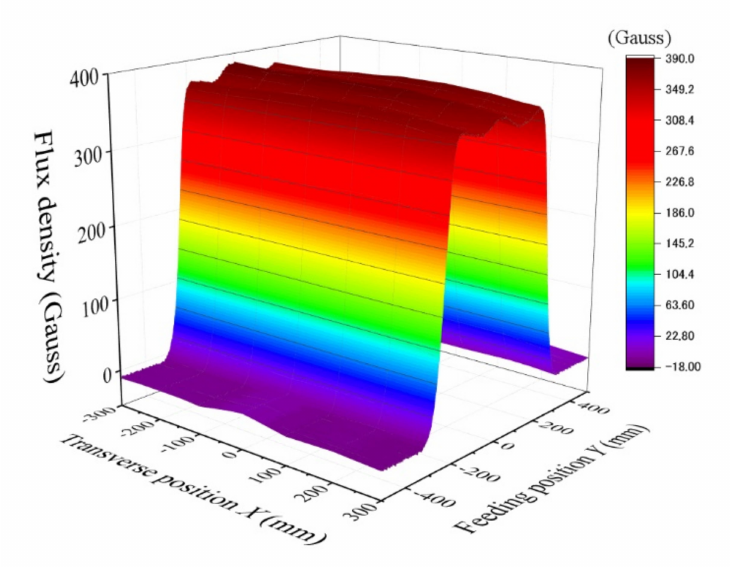
Figure 8. Measured magnetic field B z at the vertical position z = 38 mm.